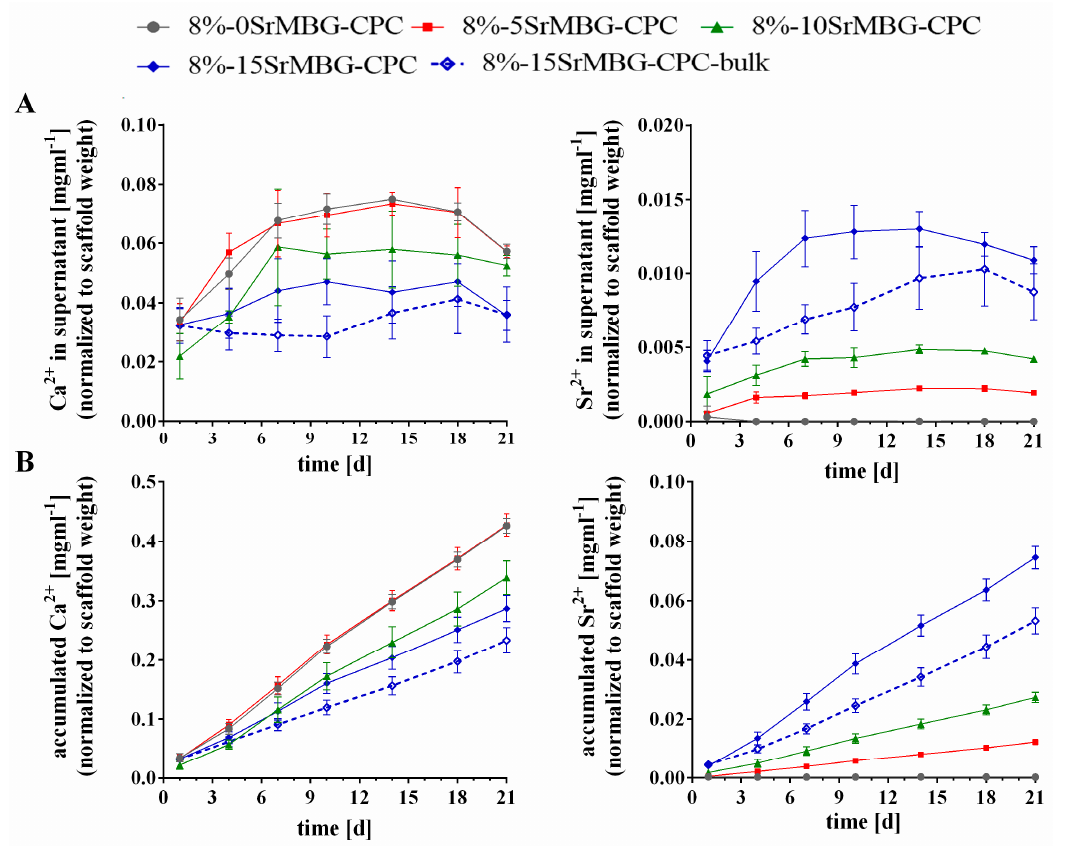
Figure 7. Release of Ca 2+ and Sr 2+ from 8%-MBG-CPC scaffolds containing MBG particles with different Sr content (0–15%) into PBS solution, quantified by ICP-OES. The determined concentrations were normalized to the weight of each sample before the incubation in PBS. ( A ) Measured release within the supernatants, ( B ) accumulated release curves (mean ± standard deviation, n = 6).